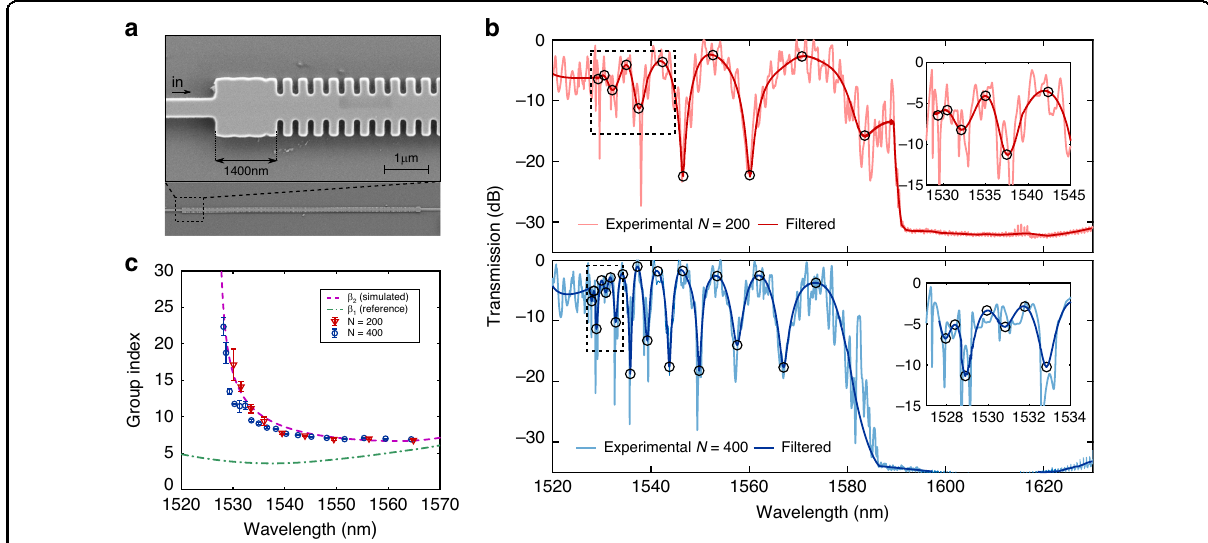
Fig. 4 Experimental measurements of slow light bimodal behaviour. a Scanning electron microscopy (SEM) image of the fabricated silicon structures without a silica cover layer. A detailed picture of the interface between the single-mode and bimodal sections is shown with the presence of a fabricated rectangular taper of ~1400 nm in length. b Normalized experimental transmitted spectra for N = 200 and N = 400 periods under a silica cover (upper and lower graphs, respectively). The spectra were normalized with respect to a reference uniform waveguide measured under the same environmental conditions. Light colours represent the raw experimental data; dark colours refer to the fi ltered signal without the Fabry-Perot ripple created in the photonic circuit cavities. Constructive and destructive interferences are indicated by the black circles in both graphs. Insets depict a close-up view of the transmission spectrum in the slow light region. c Group index experimentally obtained from the maxima and minima interference points and with the simulated fundamental mode group index as a reference. Three different experimental measurements were carried out to obtain the error bars, depicted as the data standard deviation. The dashed line represents the theoretical results obtained from the band diagram simulations, which were shifted by only 5nm towards lower wavelengths to compensate for the small fabrication